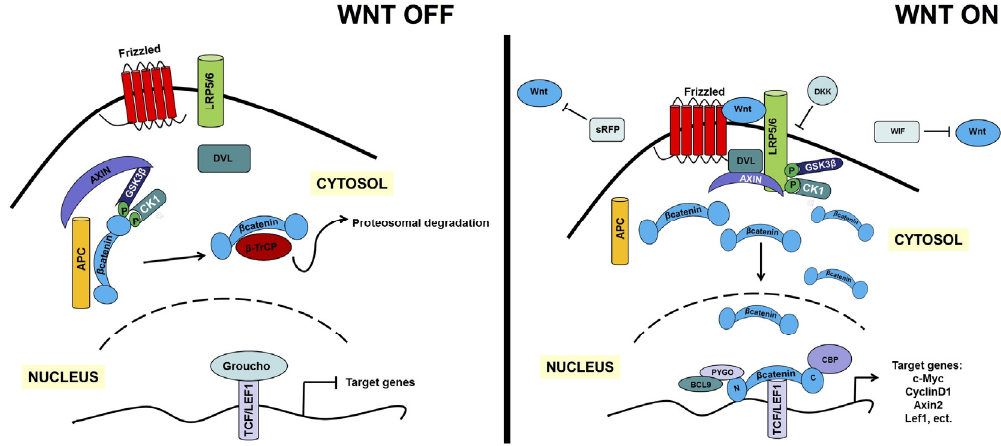
Figure 1. Schematic diagram of the canonical WNT signaling pathway. (left panel) the “WNT-Off” state: In the absence of a WNT signal, β -catenin levels in the cytoplasm are kept low through proteosomal degradation induced by the β -catenin destruction complex. Grouchos (transcriptional co-repressors) interact with TCF/LEF proteins and prevent the expression of WNT target genes. (right panel) the “WNT-On” state: When WNT ligands bind to their receptors Frizzled (FZD) and LRP5/6, the receptor complex can recruit components of the β -catenin destruction complex, resulting in accumulation of β -catenin in the cytoplasm. β -catenin will then translocate into the nucleus, replace Grouchos and recruit transcriptional co-activators to form the transcription complex with TCF/LEF proteins, which eventually promote expression of the WNT target genes.